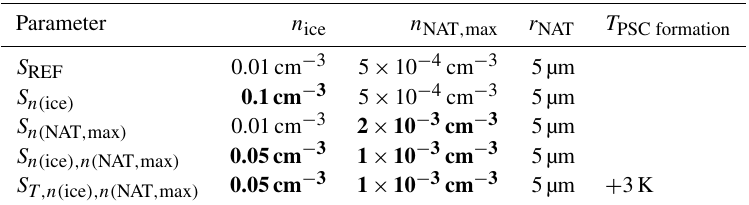
Figure 5. Time series of total PSC areal coverage over the Antarctic region as a function of altitude for winter 2007. Panel (a) is derived from CALIOP as described in Pitts et al. (2018). Panel (b) is derived from CALIOP by applying the SOCOL method (see text). Panels (c) and (d) are derived from the SOCOL reference simulation with and without applying detection limits and instrument uncertainty, respectively. Panels (e) and (f) are the same as for (c) and (d) , but with PSC formation temperature increased by 3K. Table 1. Overview of the SOCOL simulations and the microphysical parameter settings. The parameters deviating from the reference setting are denoted in